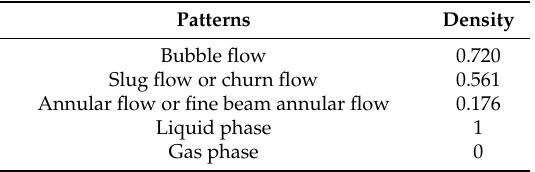
Table 3. Relationship between the patterns and densities of the